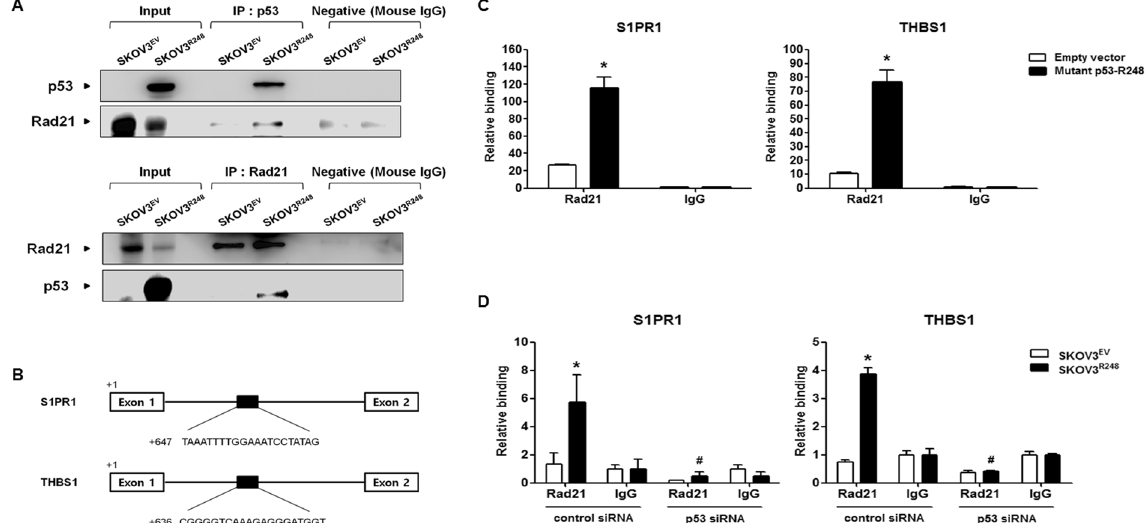
Figure 5. The effect of the mutant p53 and Rad21 interaction on the transcriptional activation of S1PR1 and THBS1 in ovarian cancer cells. ( A ) The protein interaction of Rad21 with mutant p53-R248 was determined by an immunoprecipitation assay in stably transfected SKOV3 EV and SKOV3 R248 cells. The p53 protein was immunoprecipitated using an anti-p53 antibody. The reverse immunoprecipitation (IP) was also performed using an anti-Rad21 antibody. Proteins were analyzed by western blotting using anti-p53 and anti-Rad21- specific antibodies. Data are representative of three different experiments. ( B ) The putative Rad21-binding site in the S1PR1 and THBS1 genes. ( C ) After transient transfection with mutant p53-R248 or empty vector in SKOV3 cells, ChIP assays were performed. Cross-linked DNA fragments were immunoprecipitated with the anti-Rad21 antibody, and the purified DNA was amplified by PCR using gene-specific primers for the Rad21-binding sites of S1PR1 or THBS1. ( D ) After transfection with control siRNA or p53 siRNA in stably transfected SKOV3 EV and SKOV3 R248 cells, respectively, ChIP assays were performed. Cross-linked DNA fragments were immunoprecipitated with the anti-Rad21 antibody, and the purified DNA was amplified by PCR using gene-specific primers for the Rad21-binding sites of S1PR1 or THBS1. The binding site was not detected when normal IgG was used or the antibody was omitted from the immunoprecipitation (IP) step. Data are representative of three different experiments. * P < 0.05 compared with the empty vector group or the SKOV3 EV group and # P < 0.05 compared with control siRNA transfected-SKOV3 R248